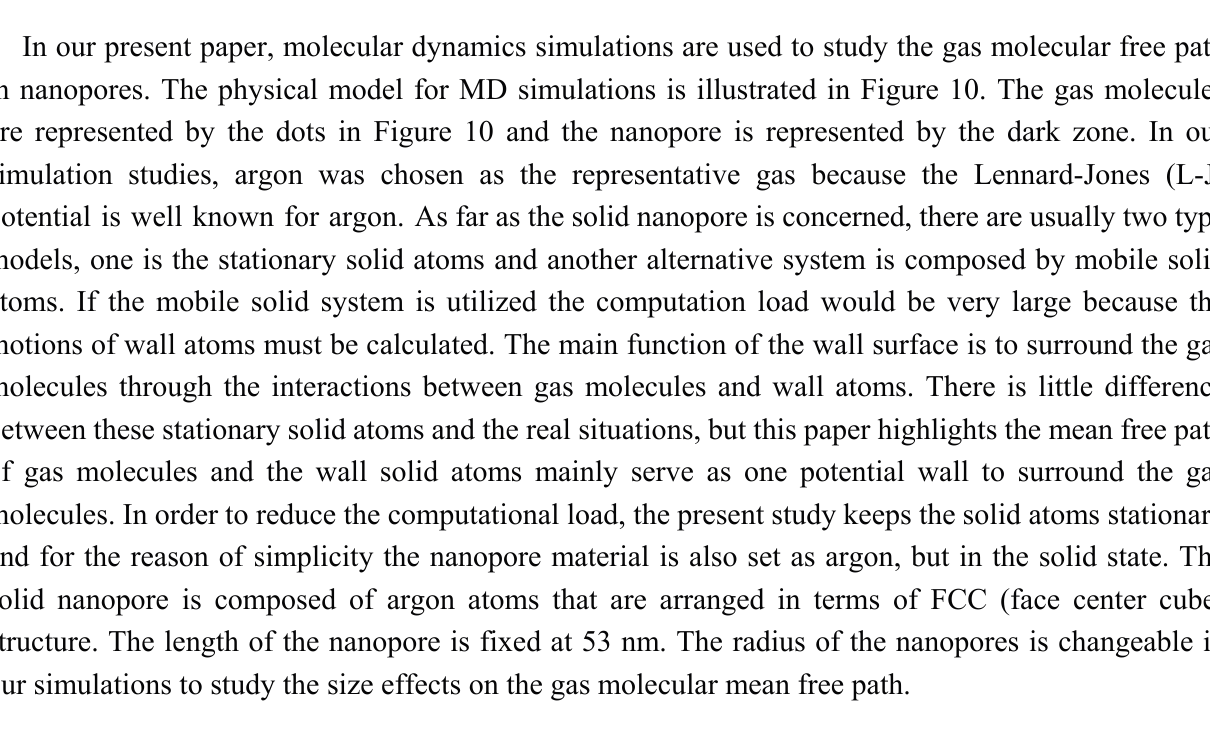
Figure 10. Cross-section snapshot of the particle locations in the nanopores of the MD (molecular dynamics)